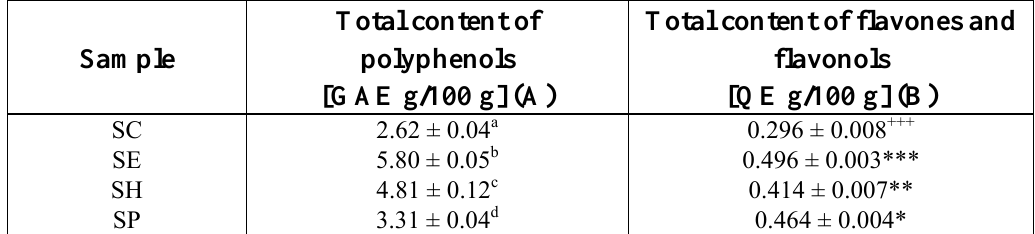
Table 3. Total content of polyphenols, flavons and flavonols in leaves water extracts.